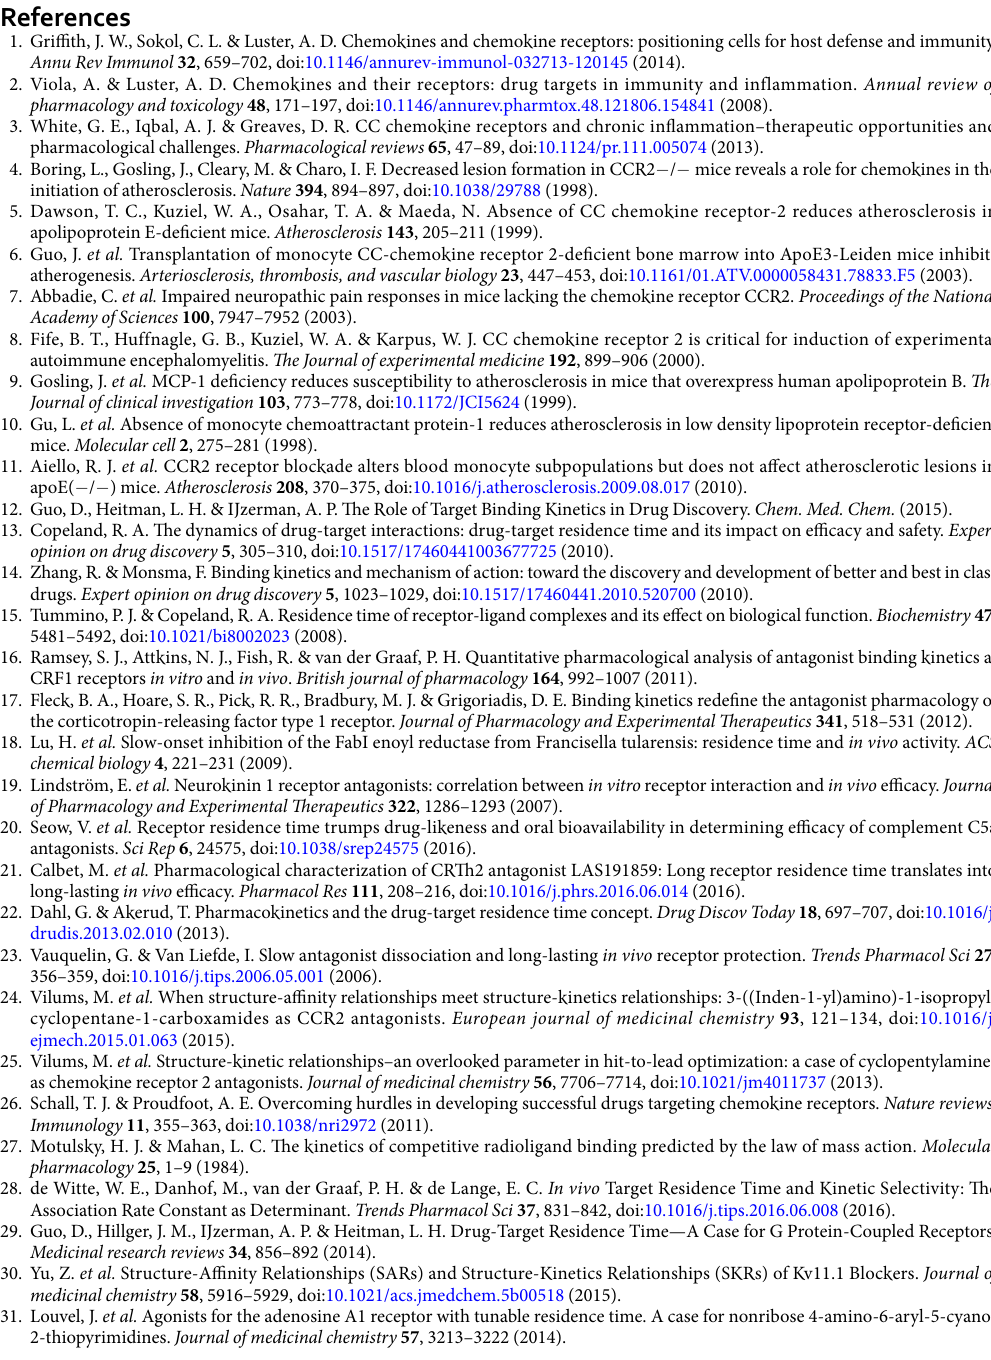
The concentration of the target-bound drug is calculated according to equation (5):